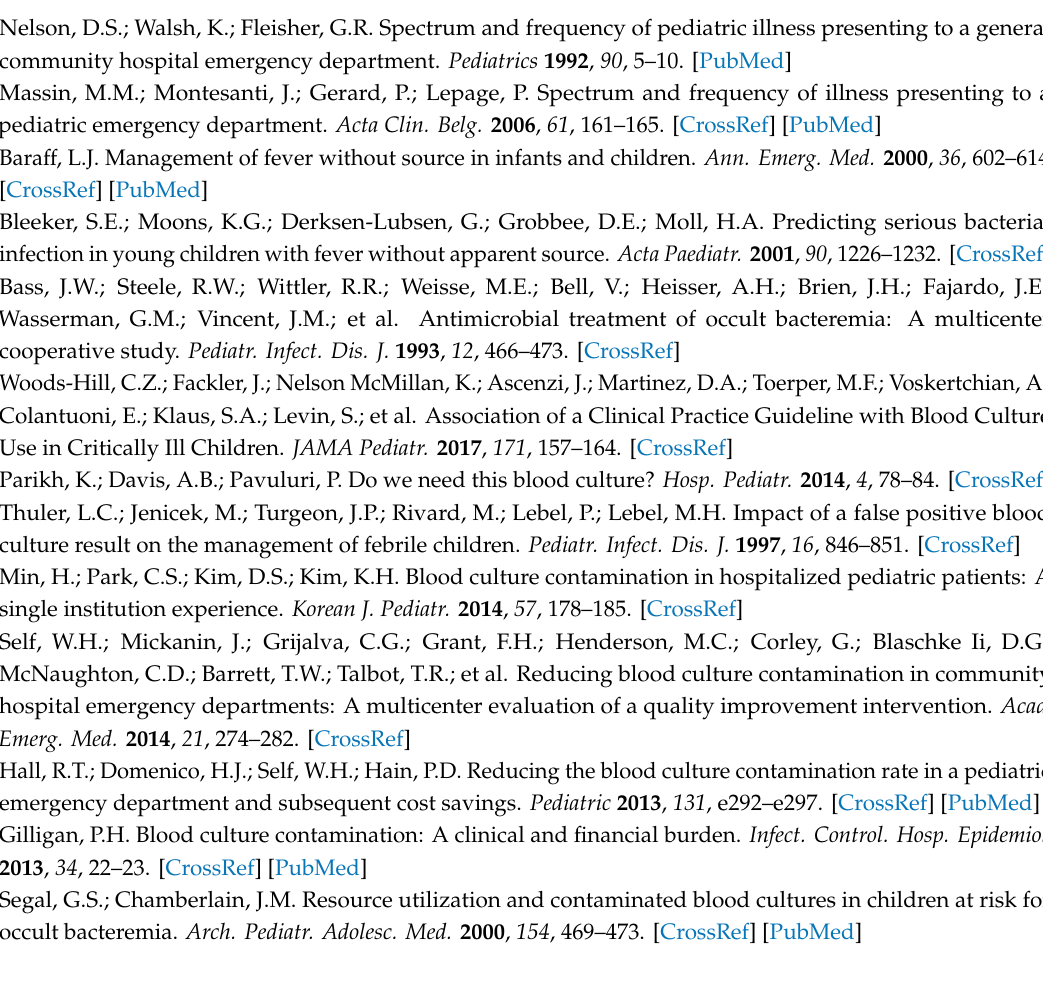
Table S1: The odds ratio of each variable and its 95%CI after repeating 100 times univariate logistic regression in subgroup study, Table S2: The maximum value, minimum value, mean value, and standard deviation of multivariate binary logistic regression coe ffi cients of significant risk factors in subgroup